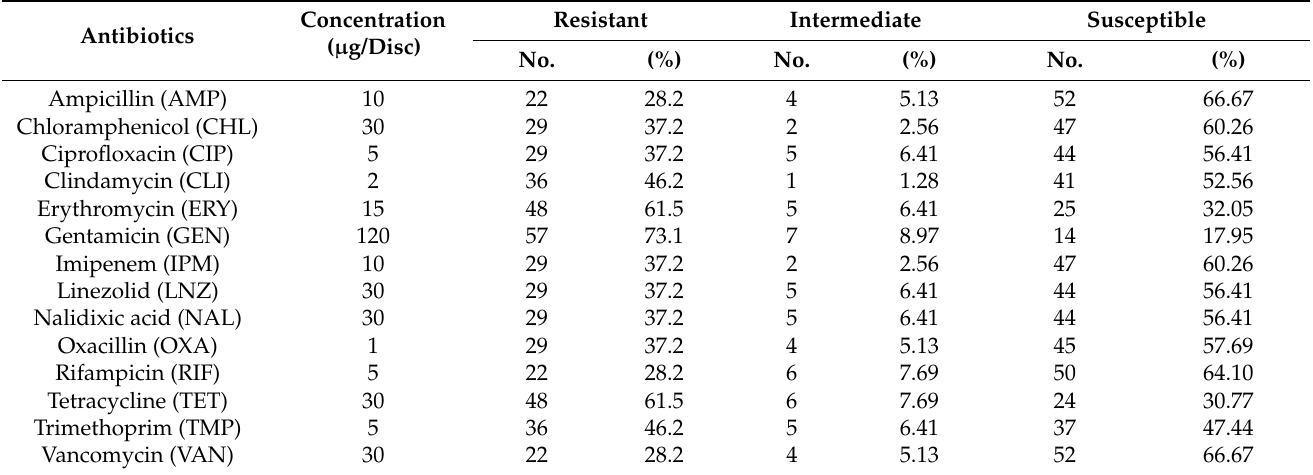
Table 1. The resistance of L. monocytogenes strains against different antimicrobial agents ( n = 78). Concentration Antibiotics